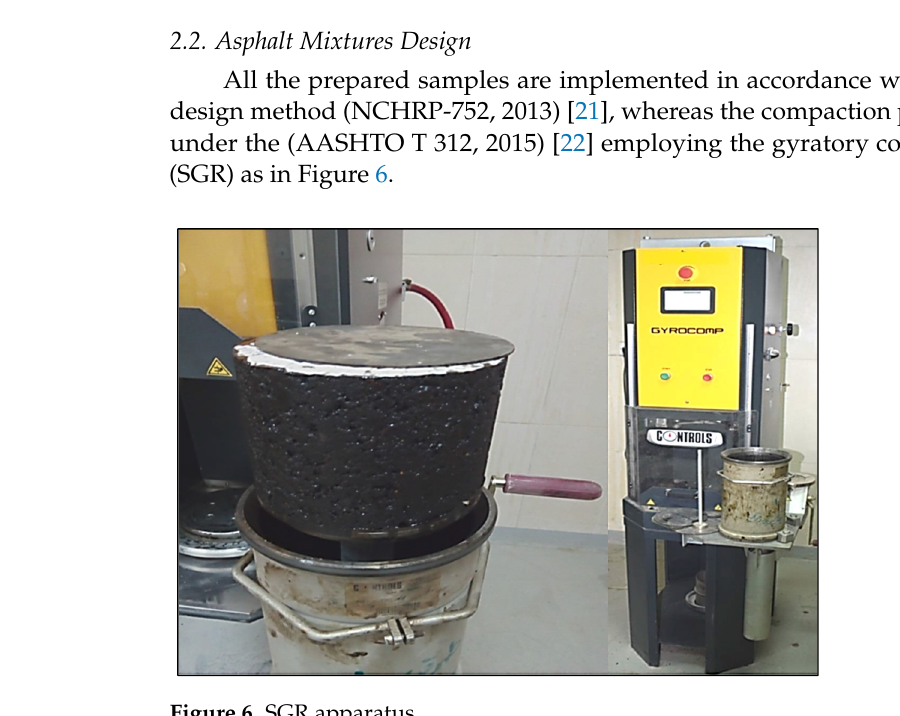
Figure 6. SGR apparatus.